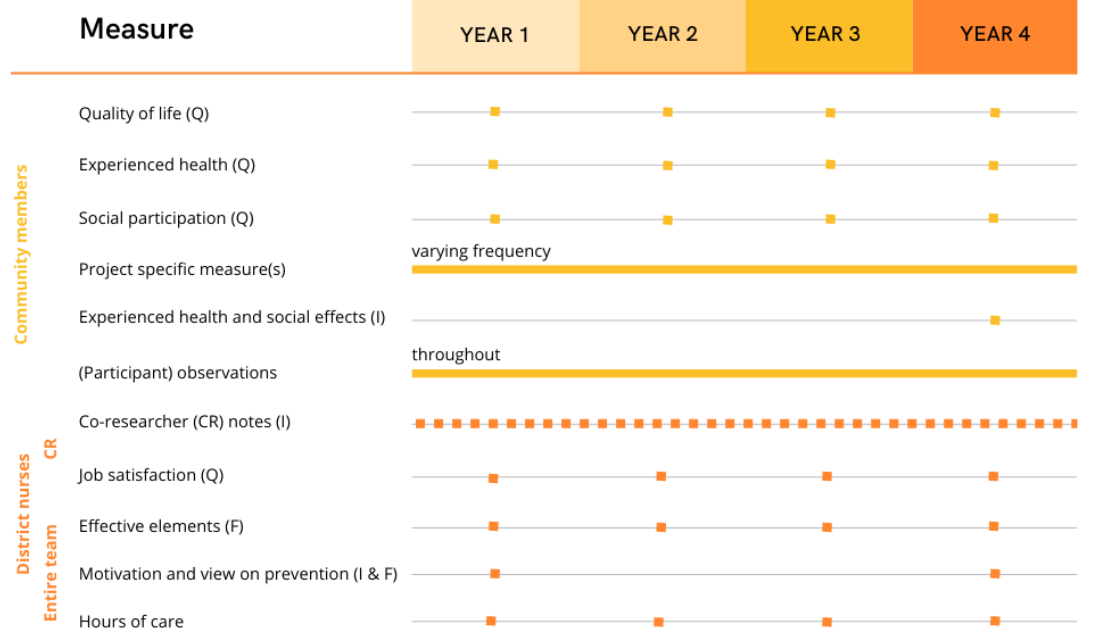
Figure 1. Impact measurements of collective prevention projects. Note: Q = questionnaire, I = Interview, F = focus group. CR = Co-researchers: the district nurses who have an active role in the development of the prevention projects.